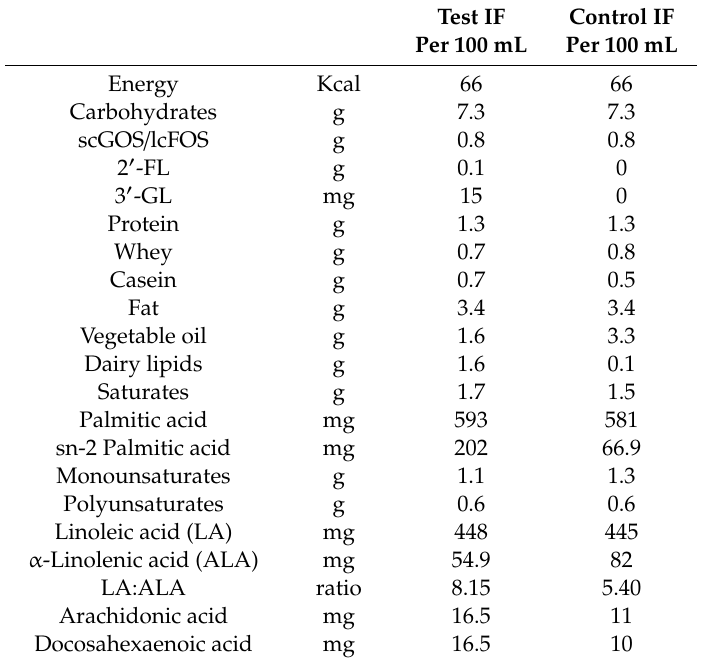
Table 1. Composition of the infant formulas provided in this intervention study 1